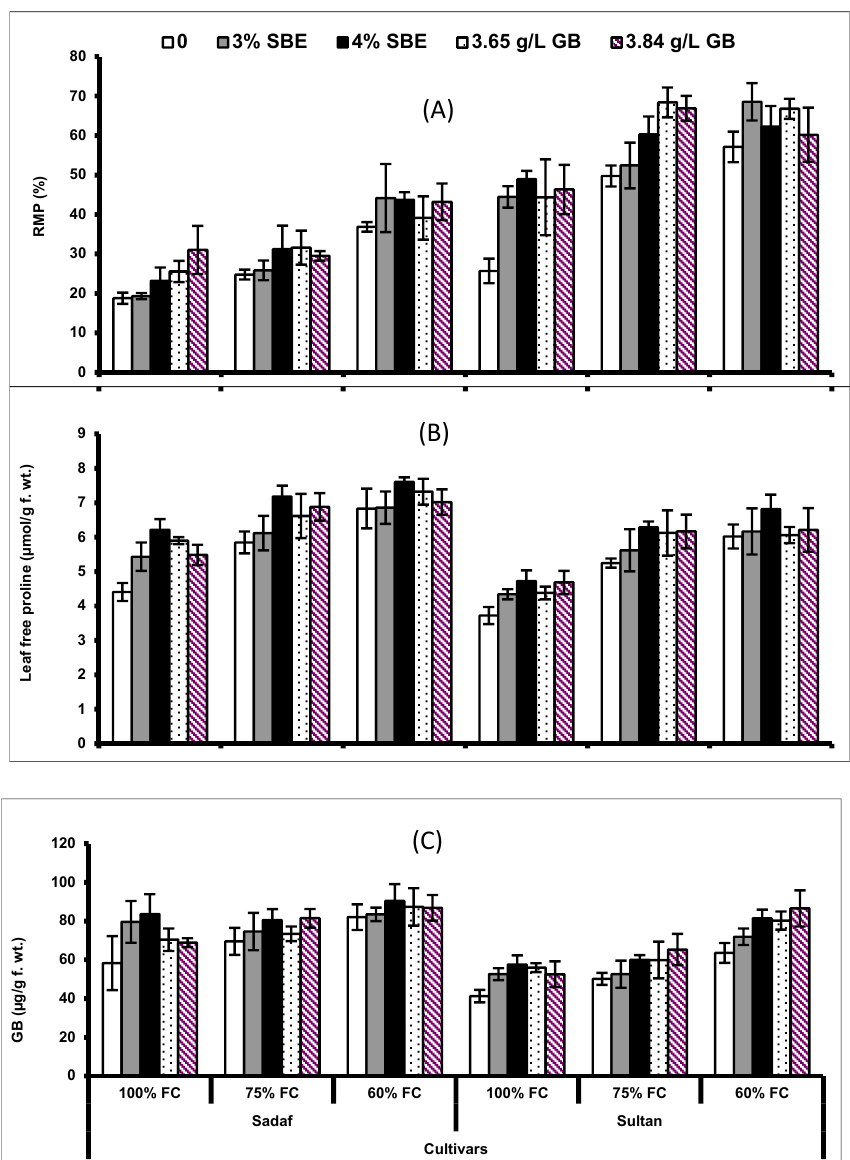
Figure 3. ( A ) Relative membrane permeability (RMP), ( B ) leaf free proline and ( C ) glycine betaine (GB) of two maize cultivars foliar-fed with varying levels of sugar beet extract (SBE) and glycine betaine under water deficit conditions (Mean ± S.E.).